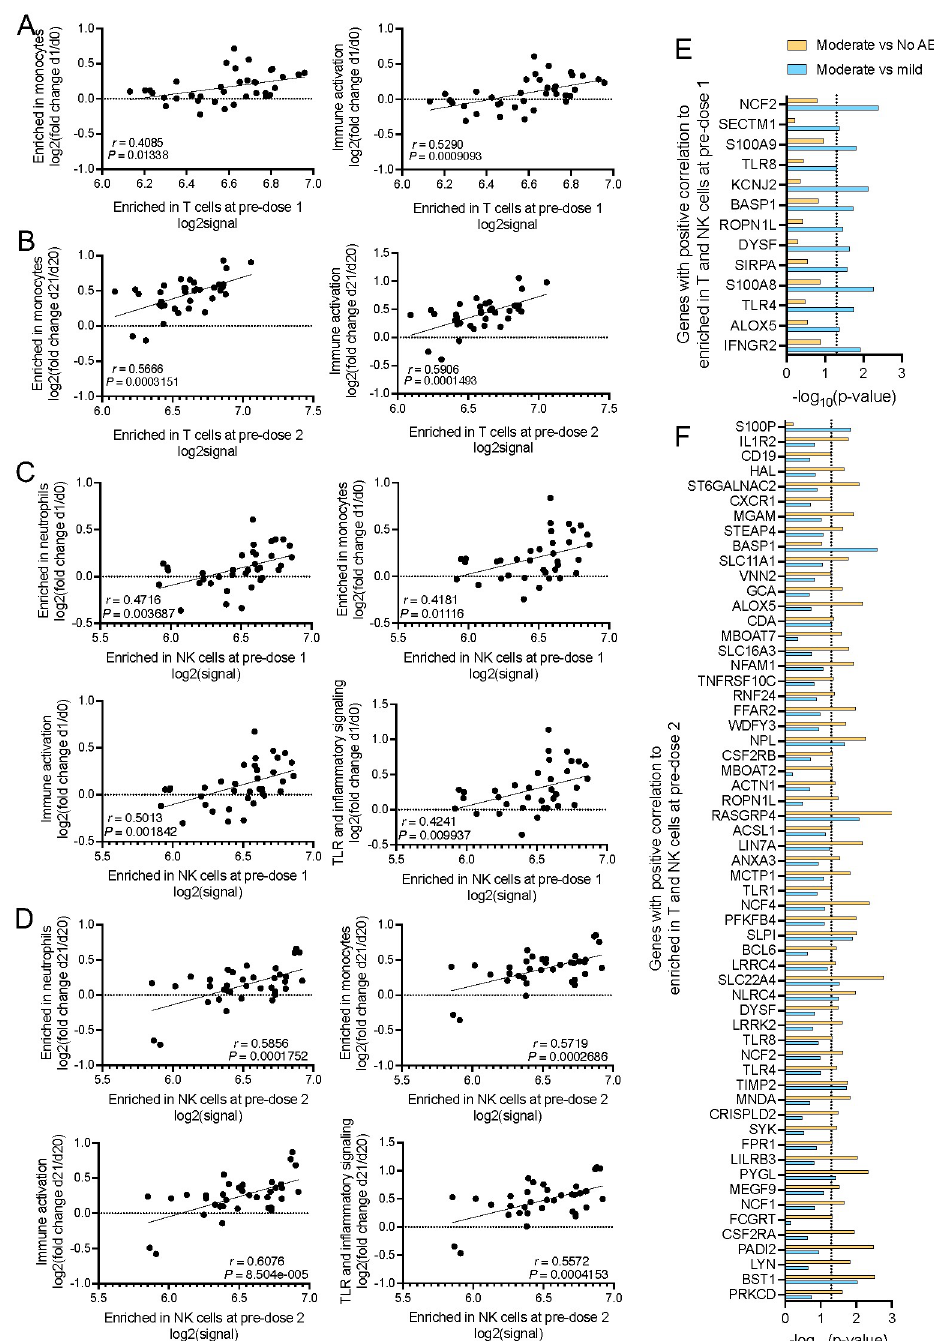
Fig 5. Baseline expression of T and NK cell associated genes were positively correlated with induction of immune genes at day 1 postvaccination. GSEA (FDR < 0.05) was performed to identify enriched gene sets in gene lists where genes were ranked according to their correlation between baseline expression of positively enriched pathways and baseline-normalized log 2 FC of genes at 1 day postvaccination. Total n = 32 participants. (A, B) Correlation for baseline expression of genes from the enriched in T-cells gene set and LEGs from the enriched in monocytes or immune activation gene sets at 1 day postdose 1 (A) or postdose 2 (B). (C, D) Correlation for baseline expression of genes from the enriched in NK cells gene set and LEGs from the enriched in neutrophils, enriched in monocytes, immune activation, and TLR and inflammatory signaling gene sets at 1 day postdose 1 (C) or postdose 2 (D). (E, F) P values from unpaired Student t test for LEGs in genes in all enriched pathways at 1 day postdose 1 (E) or postdose